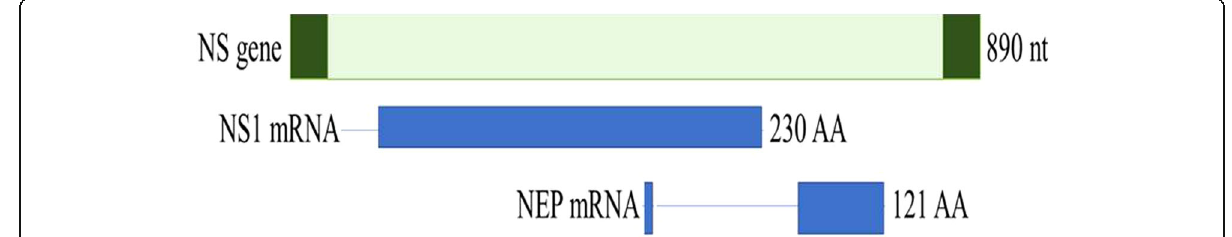
Fig. 1 Schematic representation of the non-structural protein of the influenza A virus